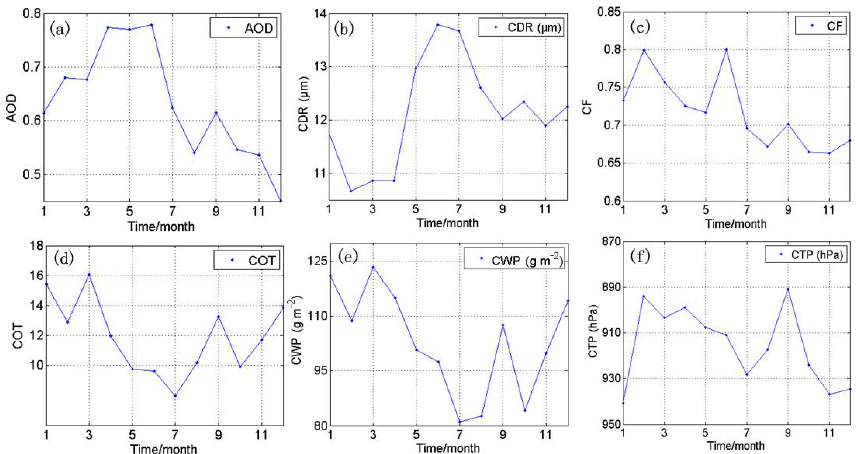
Figure 3. Time series of the monthly-averaged values of AOD (a) , CDR (b) , CF (c) , COT (d) , CWP (e) and CTP (f) for the dataset of MODIS–CALIPSO coincidences for all months between 2007 and 2010. Month 1 is